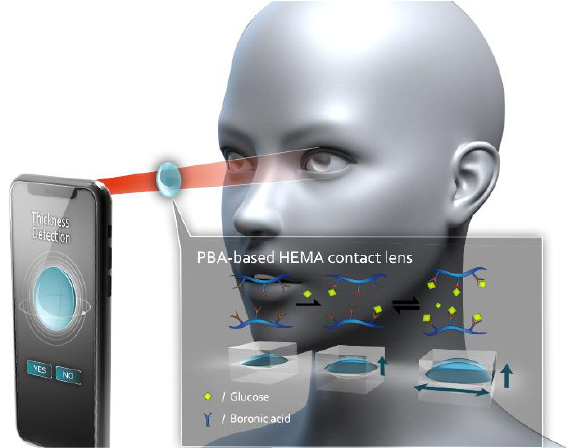
Figure 1. System of using a smartphone for detecting the thickness of the PBA-based HEMA contact lens. A portable noninvasive contact lens with an imaging program in a smartphone for an ideal method for sensing diabetes patients whose tear fluid contains glucose. The key feature is the reversible covalent interaction of boronic acid in HEMA and glucose. The volume of the PBA-based HEMA changes simultaneously with the glucose level.